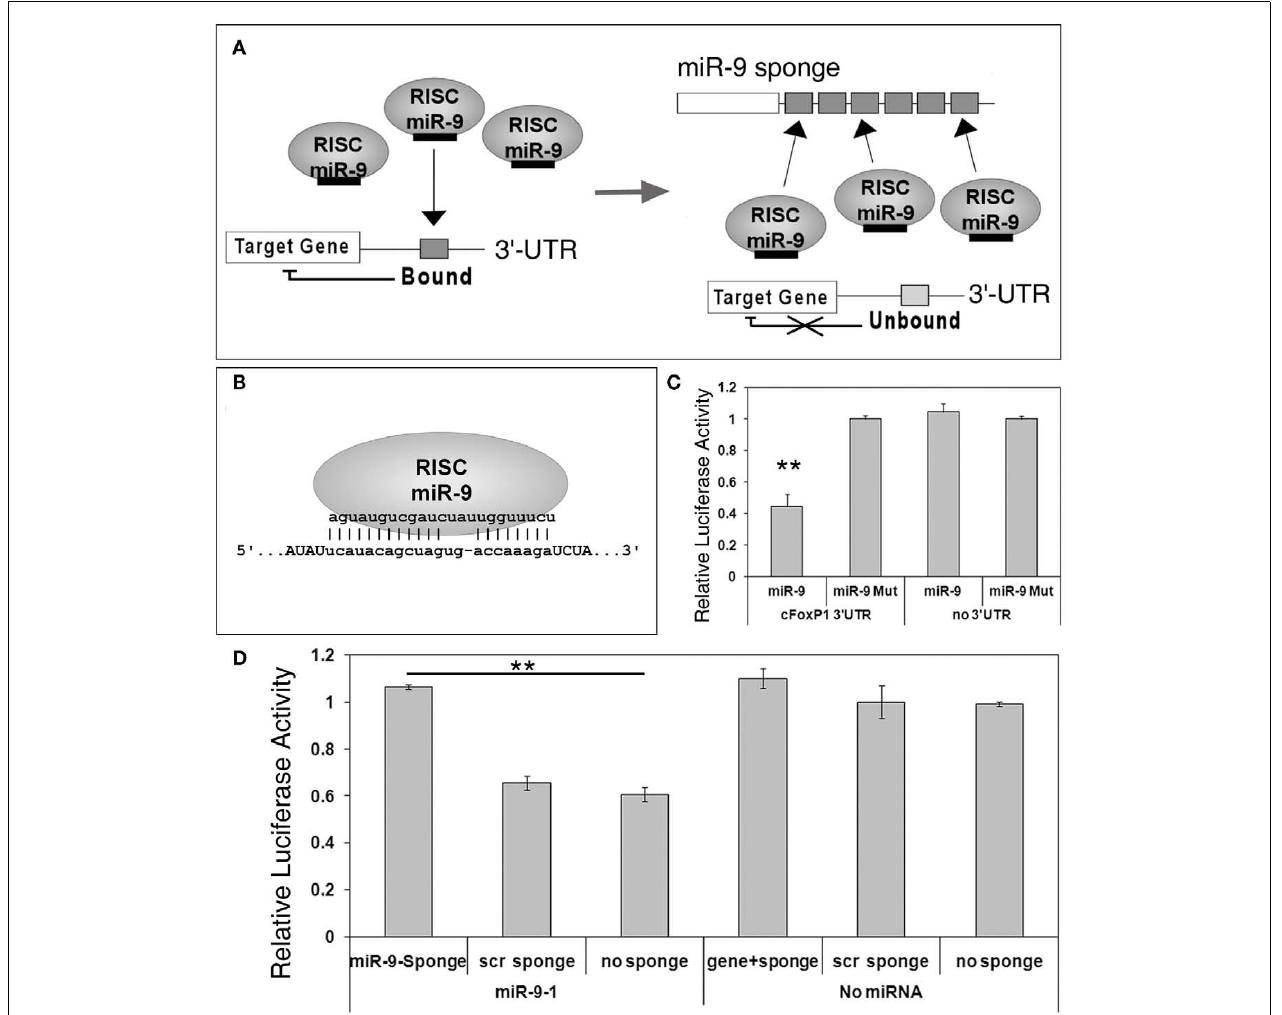
binding site, designed with an internal bulge, permits a specific interaction with endogenous miR-9. (C) FoxP1 3 (cid:2) -UTR luciferase activity was significantly reduced when co-expressed with miR-9, but not miR-9 mutation (miR-9-Mut). n = 3, ** p < 0.002. (D) miR-9 sponges, but not sponges with scrambled binding sites (scr sponge), were able to relieve repression of miR-9 on FoxP1 3 (cid:2) -UTR, as detected by increased luciferase activity. n = 3, ** p <